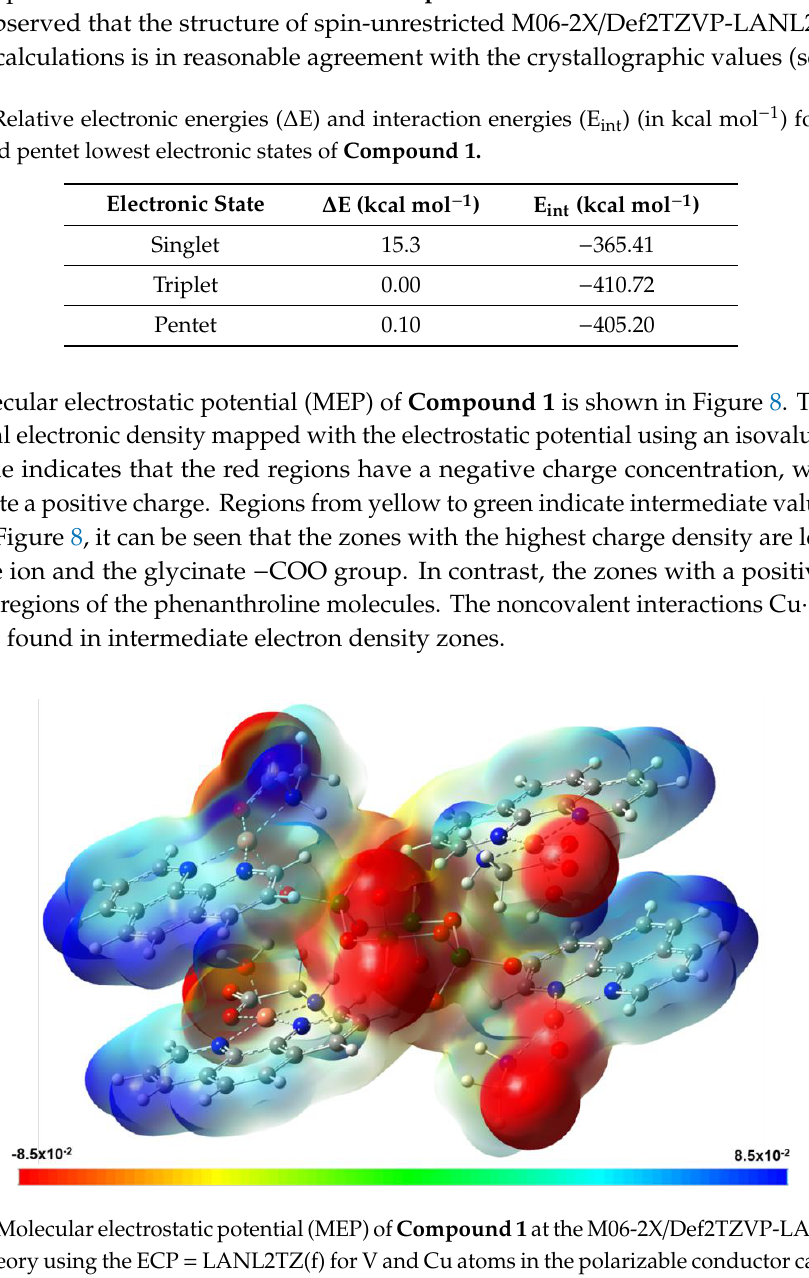
Figure 8. Molecular electrostatic potential (MEP) of Compound 1 at the M06-2X/Def2TZVP-LANL2TZ(f) level of theory using the ECP=LANL2TZ(f) for V and Cu atoms in the polarizable conductor calculation model (CPCM) model and water solvent.